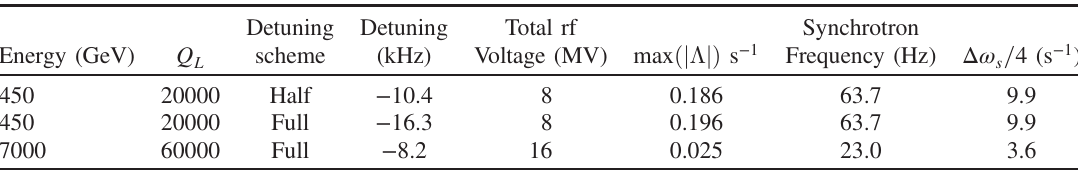
TABLE II. Maximum value of j Λ n j over all n caused by the impedance of the eight cavities at the fundamental. OTFB